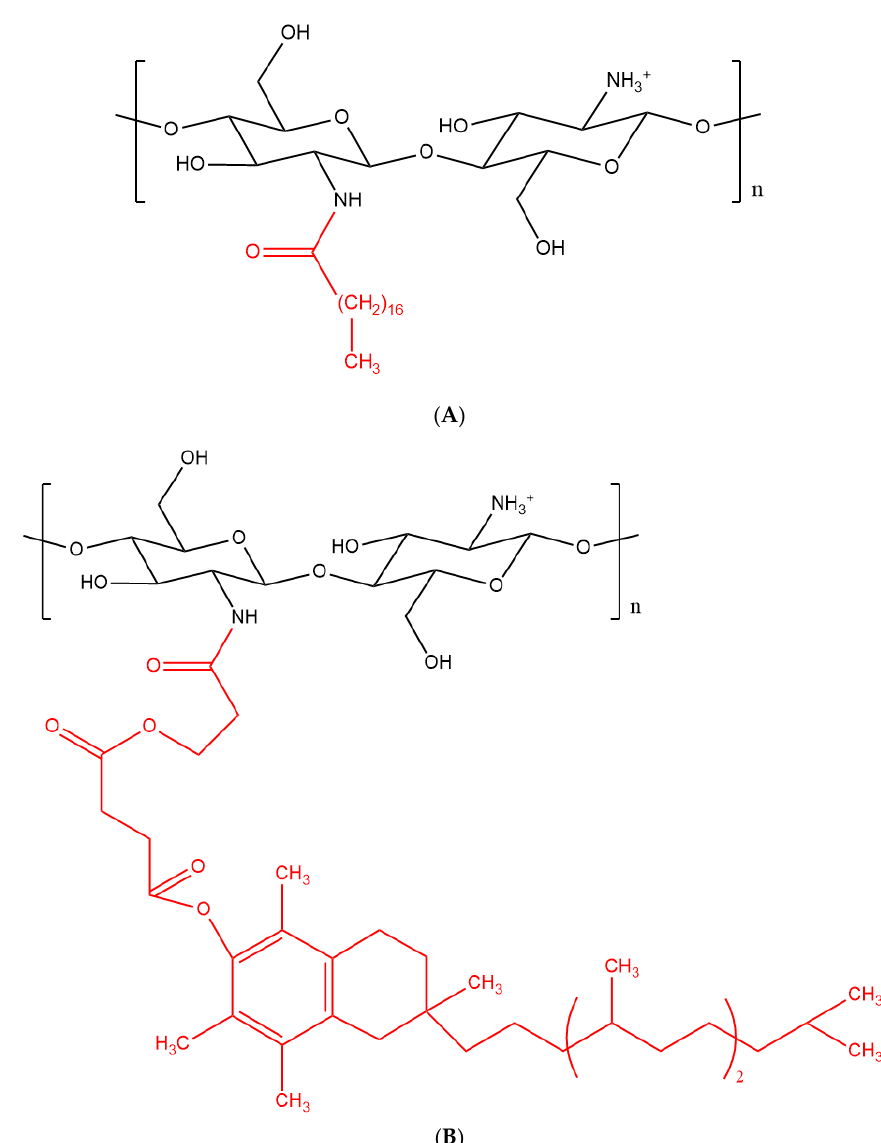
Figure 7. Structure of chitosan functionalised with ( A ) stearic acid (shown in red) and ( B ) d- α -tocopherol PEG 1000 succinate (shown in red).